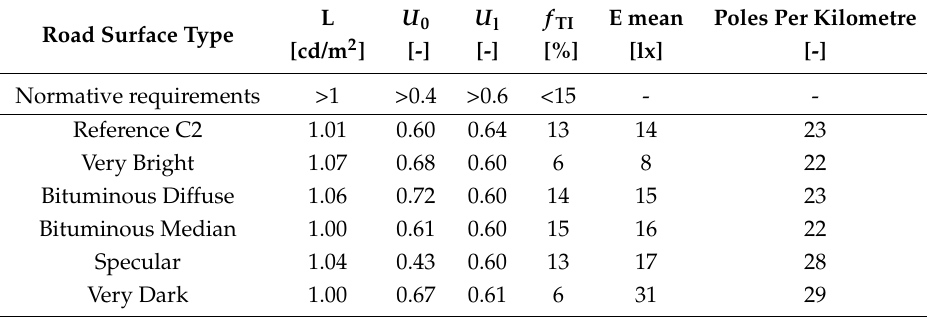
Table 8. Road lighting designed values for Case B.